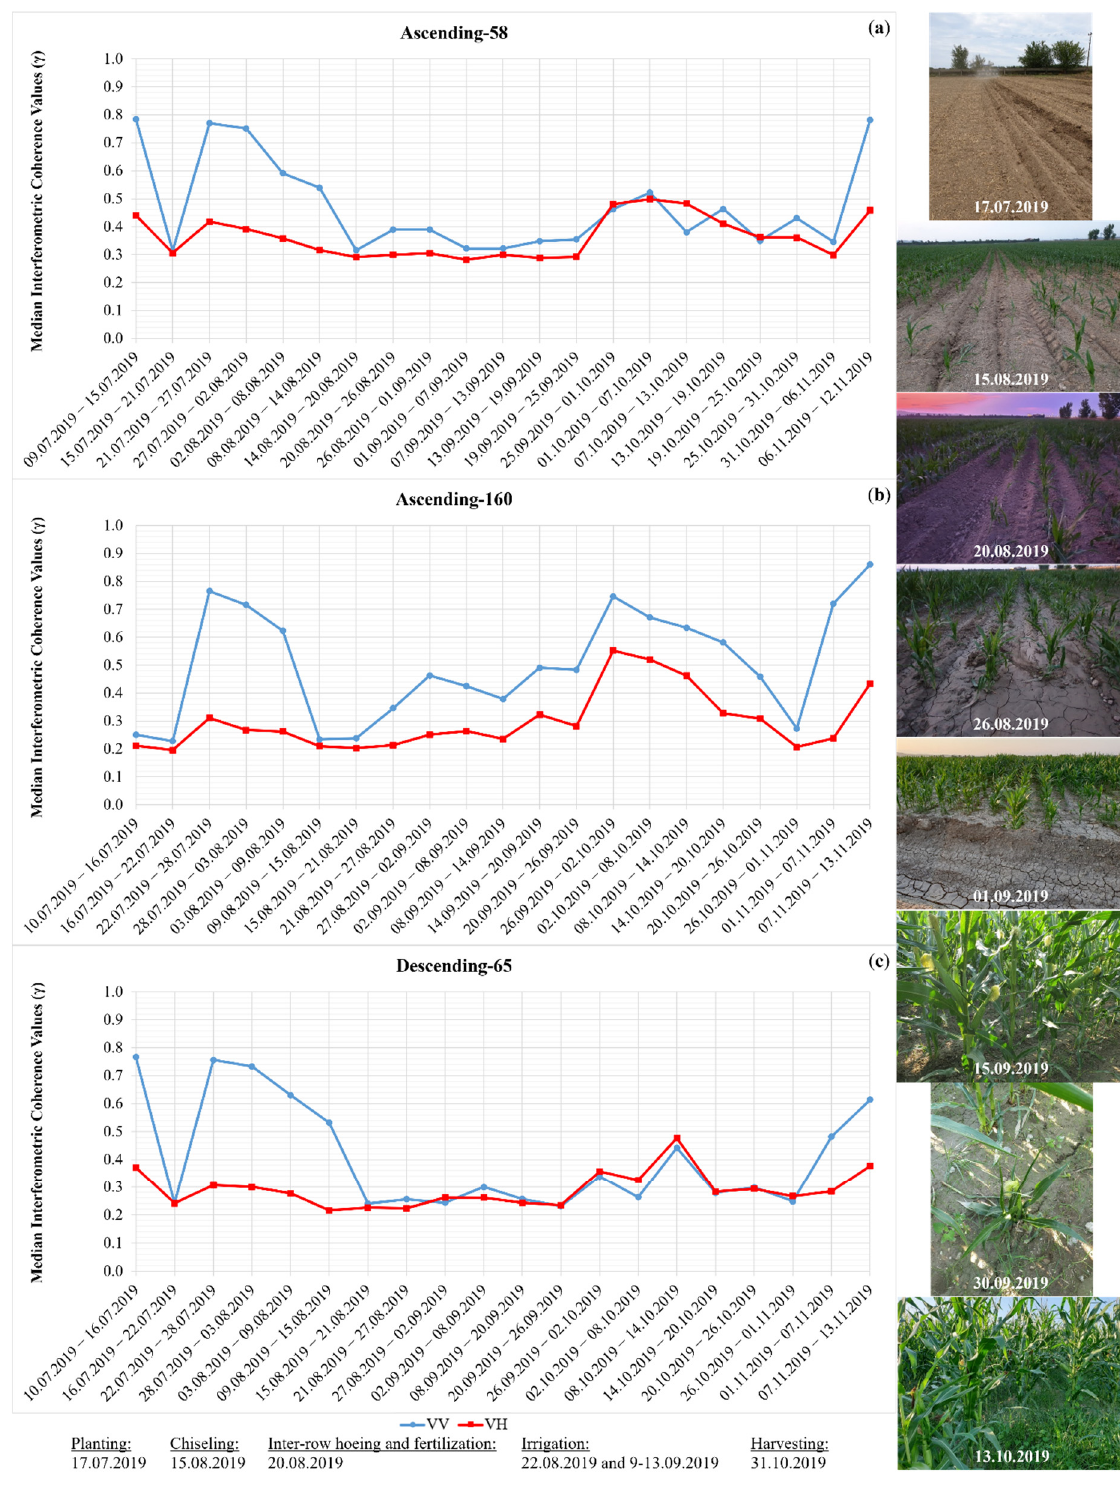
Figure 9. Median interferometric coherence values ( γ VV and γ VH ) of Sentinel-1 satellite image pairs acquired from ( a ) Ascending-58 orbit, ( b ) Ascending-160 orbit, and ( c ) Descending-65 orbit for the study area.